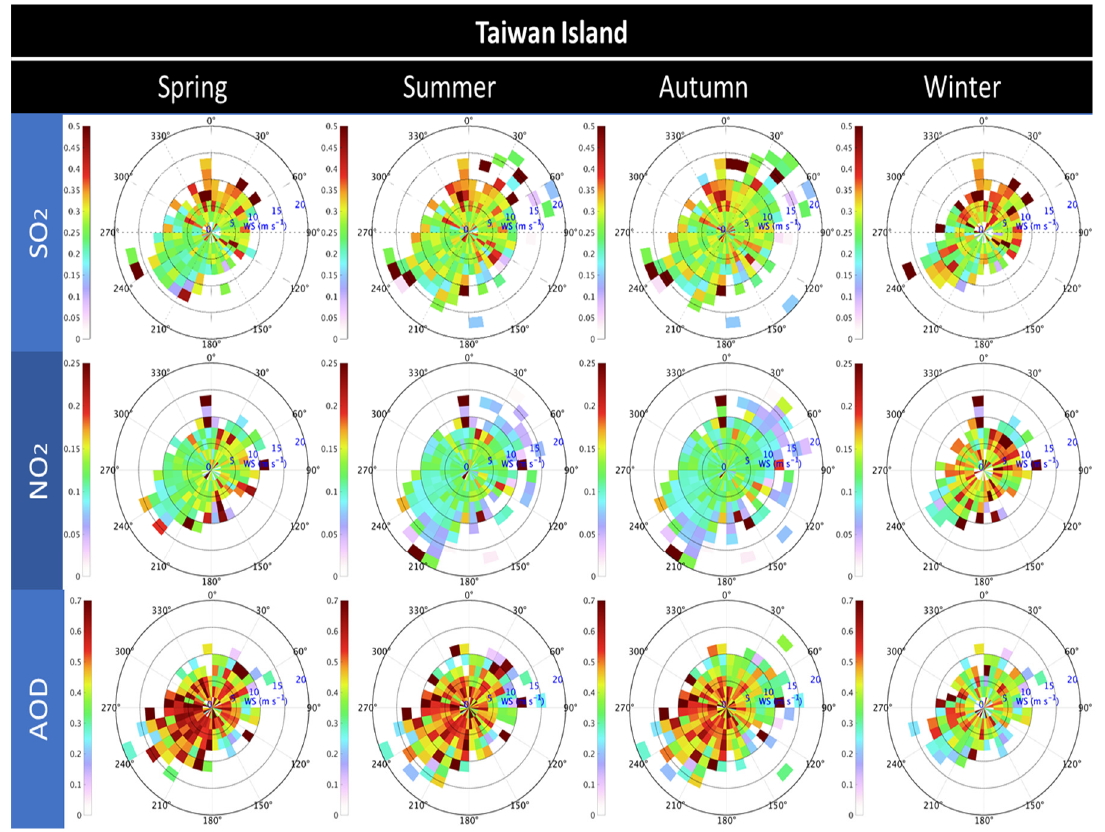
Figure 10. Summary of wind dependency of SO 2 , NO 2 , and AOD in Taiwan Island for each season. The shading color indicates the value of SO 2 , NO 2 , and AOD. The radial direction and radial distance represent the wind direction and wind speed at 850 mb, respectively.